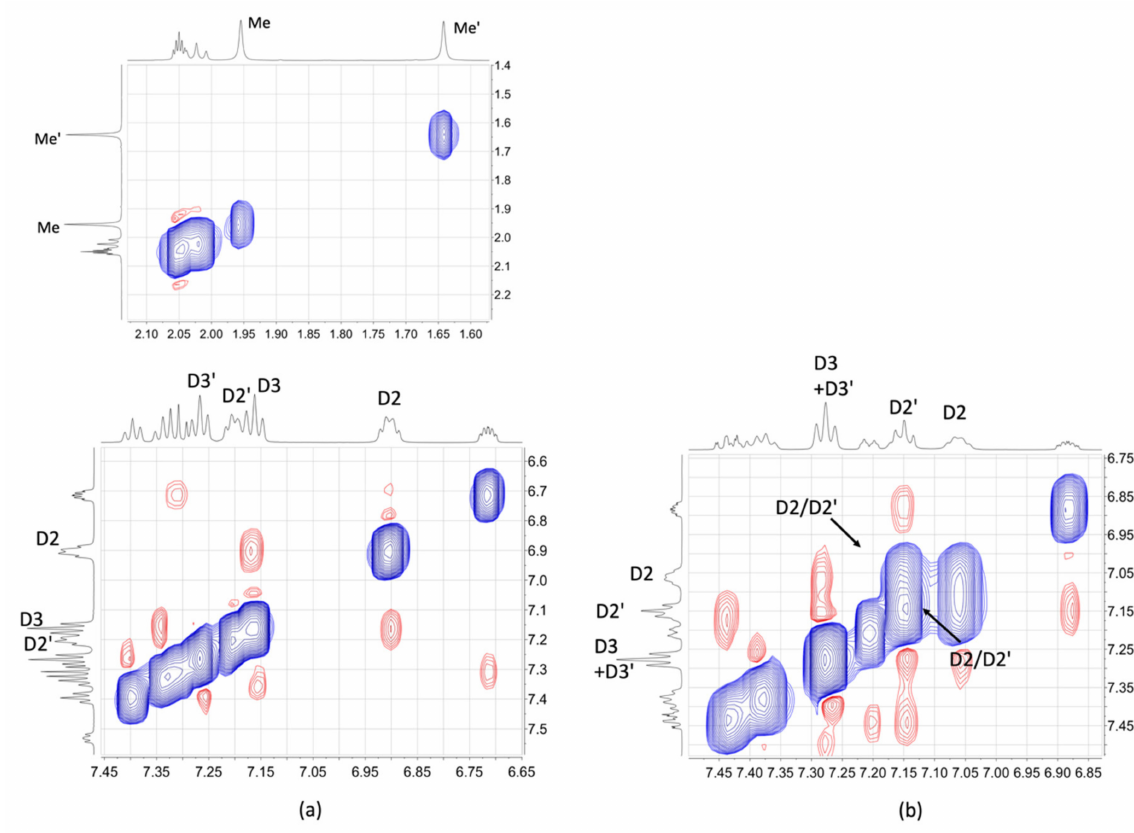
Figure 6. Part of the NOESY spectra (500 MHz, acetone-d 6 , 298 K) of ( a ) [Cu(xantphos)( 1 )][PF 6 ] with the methyl region shown at the top, and ( b ) [Cu(POP)( 1 )][PF 6 ]. EXSY peaks appear in the opposite phase (blue) to NOESY crosspeaks (red), and are observed between H D2 and H D2 (cid:48) in [Cu(POP)( 1 )][PF 6 ] but not in [Cu(xantphos)( 1 )][PF 6